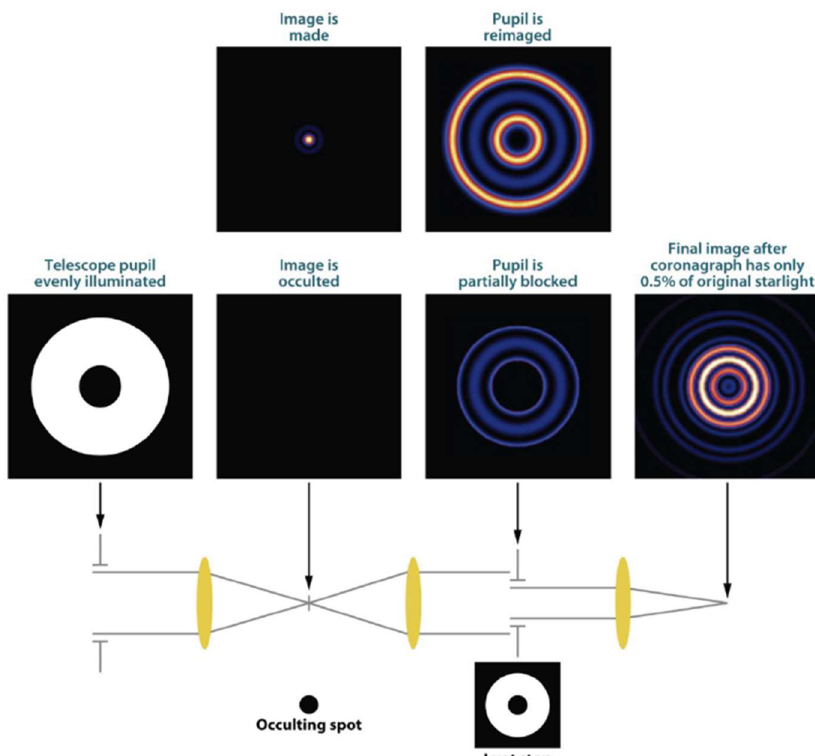
Figure 9. Optical design of a basic Lyot coronagraph for monochromatic radiation. The mask (or occulting spot) is located in the image plane and blocks the stellar radiation. After, the pupil is partially blocked to suppress the diffraction rings. After the coronagraph, the stellar image is a set of rings with a 0.5% of the original stellar flux (for this particular design from A. Sivaramakrishnan). The figure comes from [25].